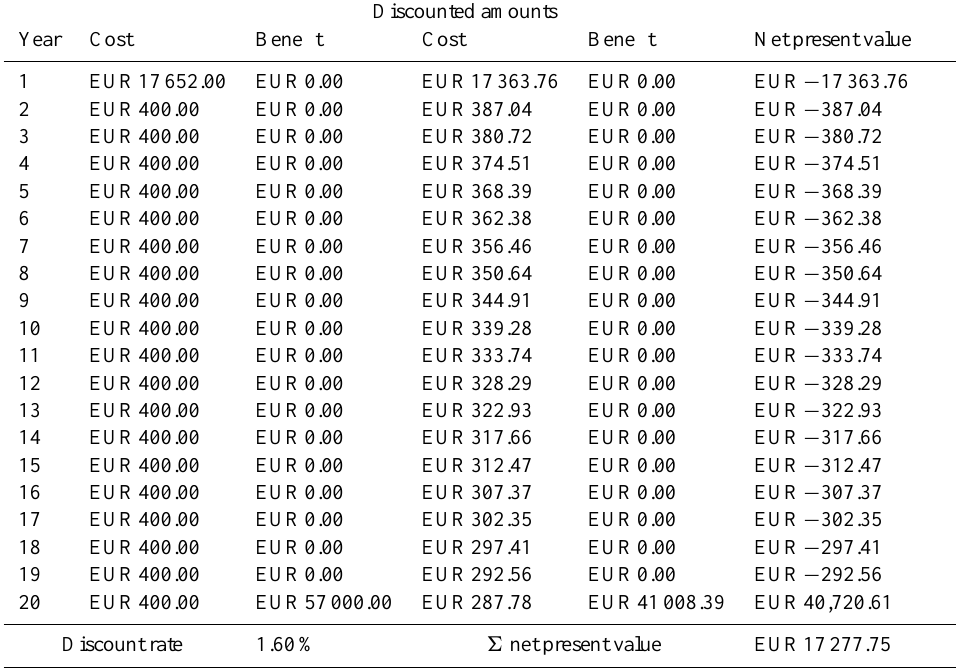
Table 2. Cost/benefit analysis for the Carrè landslide: total remedial costs of EUR57000 were considered a benefit which had to be reduced by the prevention and maintenance costs. The final saving was obtained by summing all years’